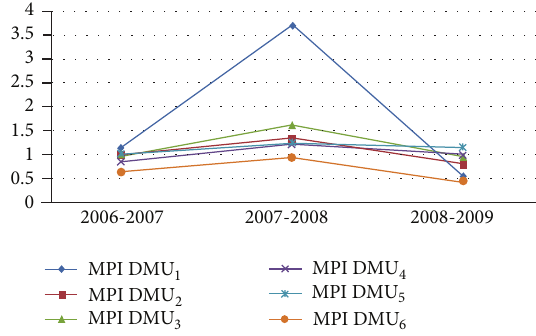
Figure 1: Malmquist Productivity Index.